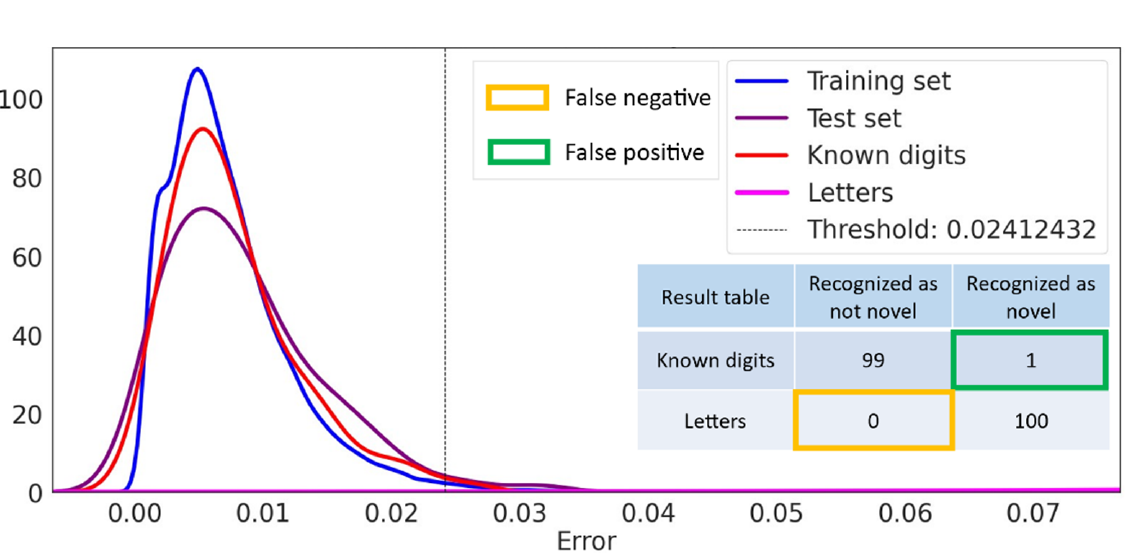
Training set Randomly selected 30,000 digit images from MNIST-dataset Test set Randomly selected 12,500 digit images from MNIST-dataset The autoencoder aims to minimize the mean squared pixel-wise deviations between raw and reconstructed images during training. The percentile of the empirical cumulative distribution of reconstruction errors for the training set (cf. Table 1) was decided as the threshold to identify known and unknown data. In the case of an image, if the reconstruc- tion error falls below this threshold, the input image is classified as known, otherwise as unknown (novel).